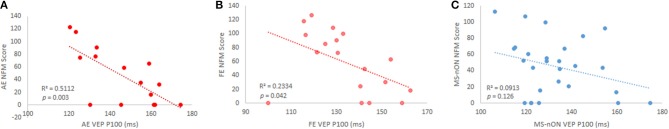
VEP P100 latency and NFM score correlations in subgroups. (A) MS-ON AE (p = 0.003); (B) MS-ON FE (p = 0.042); (C) MS-nON (p = 0.13).